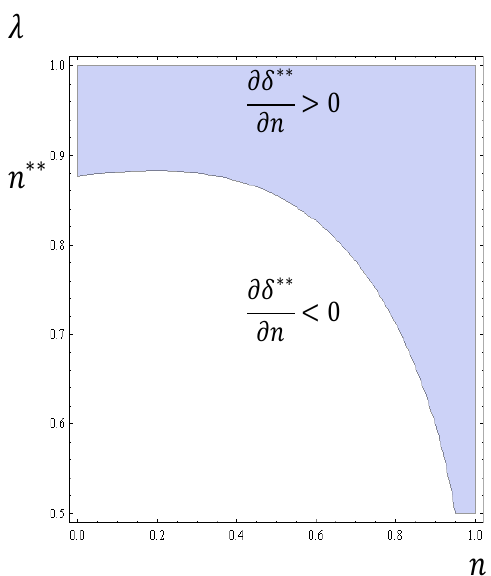
Figure 2. Cost asymmetry and network effects. (**: critical value of variable)